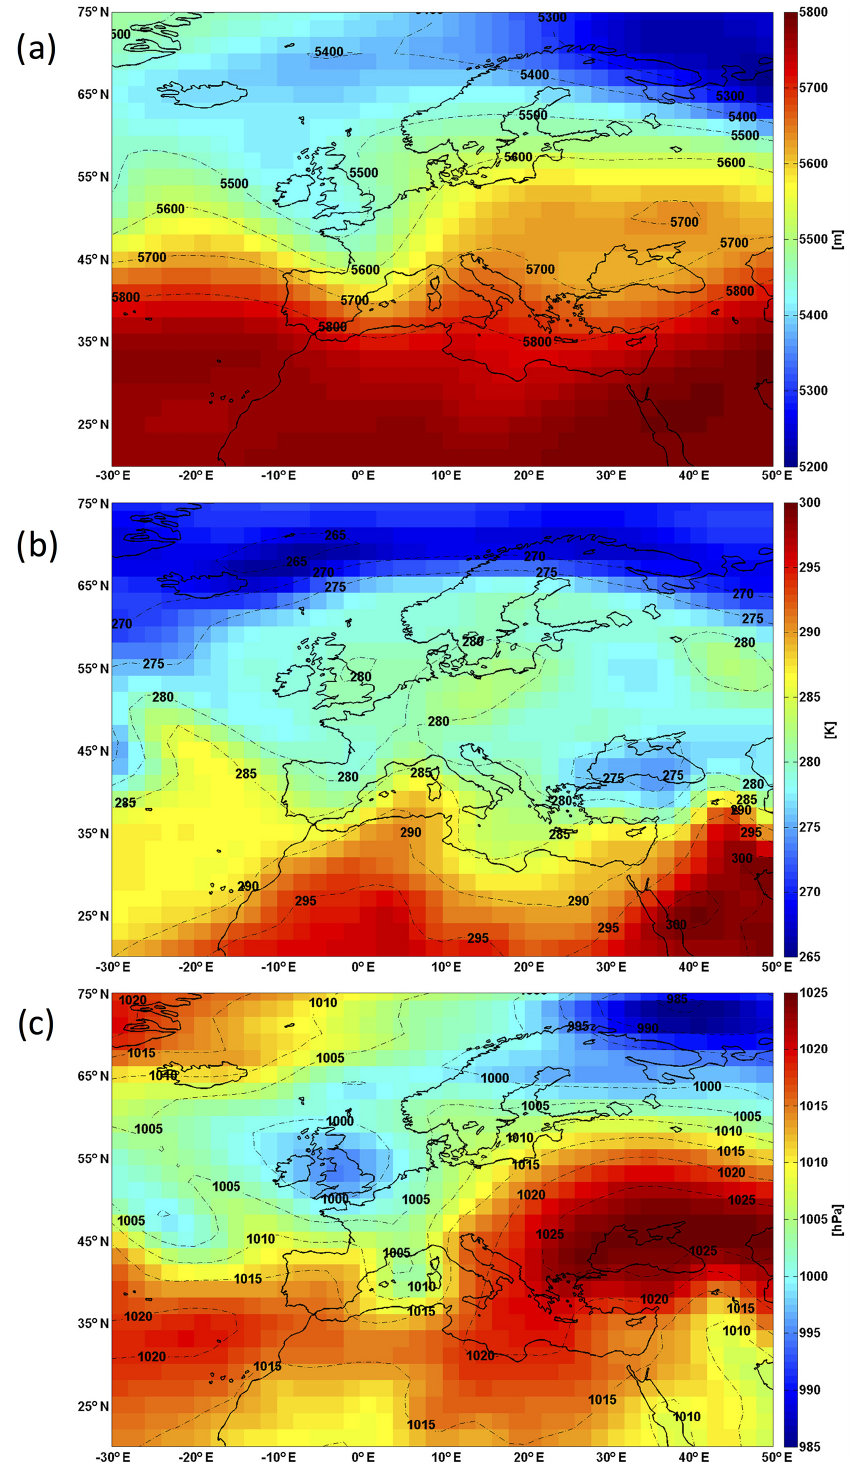
Figure 2. Image panels show the following: (a) 500hPa geopotential, (b) 850hPa temperature and (c) sea level pressure on 25 Septem- ber 1915 at 06:00UTC (20th Century Reanalysis Project mean fields over the 56 ensemble members).